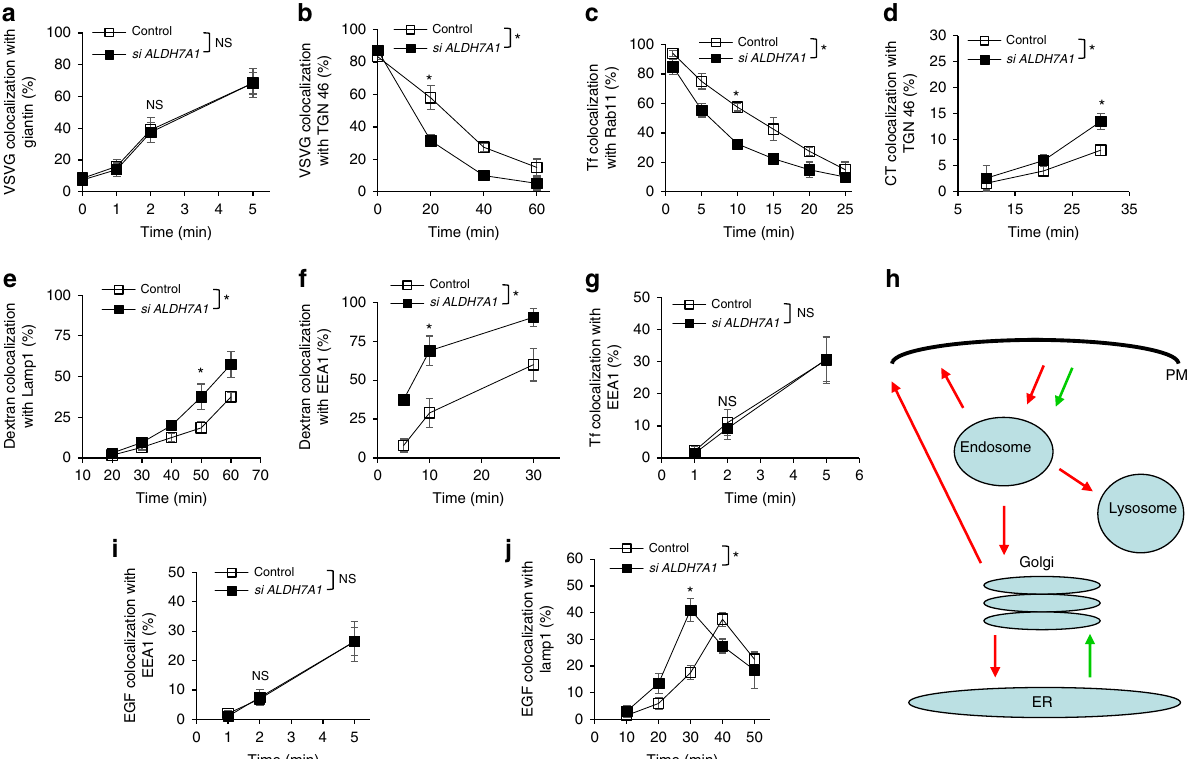
Fig. 2 Knocking down ALDH7A1 enhances intracellular pathways. Quantitative results are shown as mean with standard deviation; * p <0.05, NS not signi fi cant, paired two-tailed Student ’ s t -test; n = 3 independent experiments. Source data are provided as a Source Data fi le. HeLa cells were assessed for